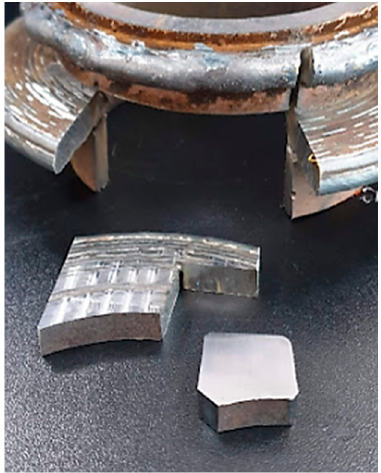
Figure 19. Preparation for resin incorporation. Preparation for resin embedding (Figure 18). Embedding in resin and grinding/polishing (Figure 20).